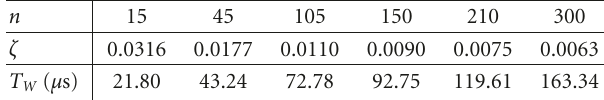
Table 3: Analysis results for ζ and T W in DCF.